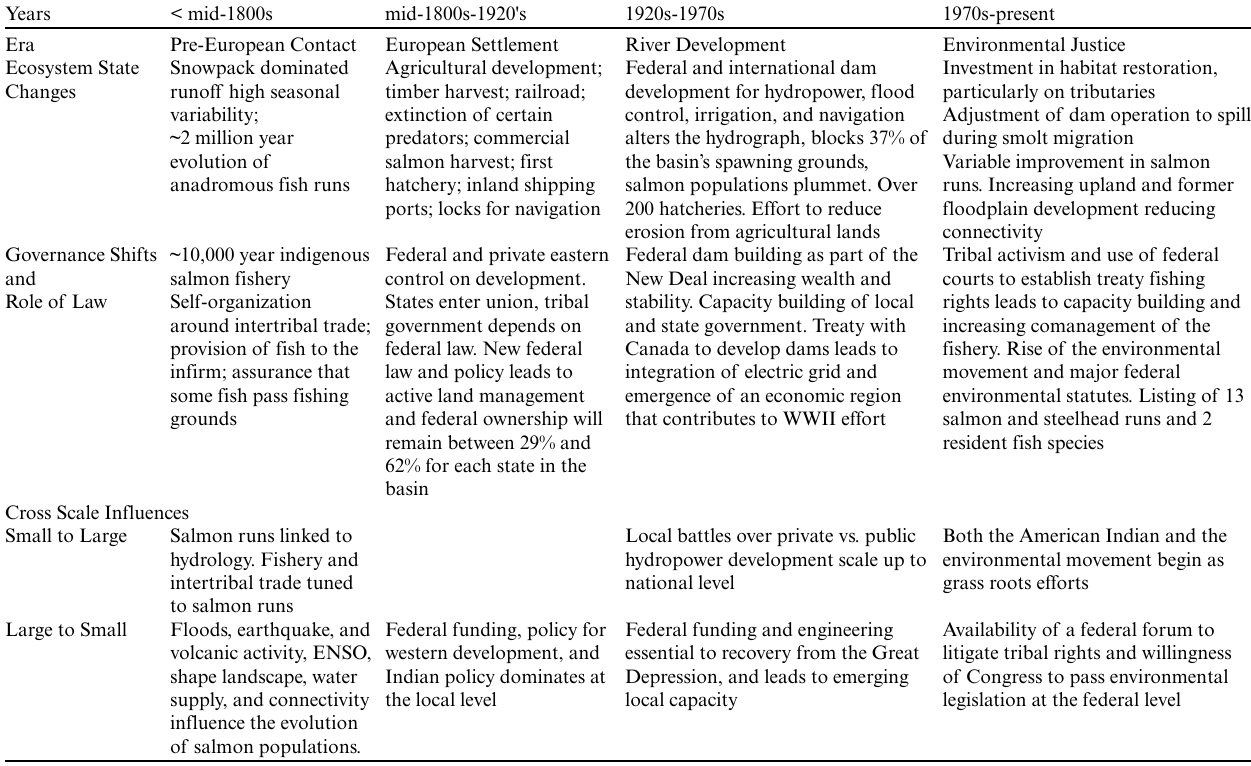
Table 4 . Assessing system resilience and ecosystem services in the Columbia River Basin. Situated in the Pacific Northwest of the United States and Canada, the Columbia River Basin has undergone two major transformations in recorded history as a result of social-ecological interaction and is on the cusp of a third as shown in the table below. The two transformations during the 19th and 20th centuries led to increasing optimization of key services through engineered development of the river system, which in turn led to substantial increases in wealth and well-being among the European settlers and their descendants in the region. Corresponding to this optimization and increase in human capital, is a general reduction in natural capital across the broad array of ecosystem services present prior to European settlement. This in turn both reduced the latitude for adaptation (one component of resilience) and hardened dependence on historic amount and timing of water supply, leaving the basin vulnerable to climate change. The third transition which began with a growing recognition of environmental values and the rising voices of formerly marginalized Native American tribes and First Nations, has not yet transformed the social-ecological system in the basin, but has the potential for reconciliation of the development needs of modern society with ecosystem function through integrated modernization of both the engineered system and its governance. The table focuses on the U.S. portion of the basin except where international cooperation on river development is relevant. Eighty-five percent of the basin is in the United